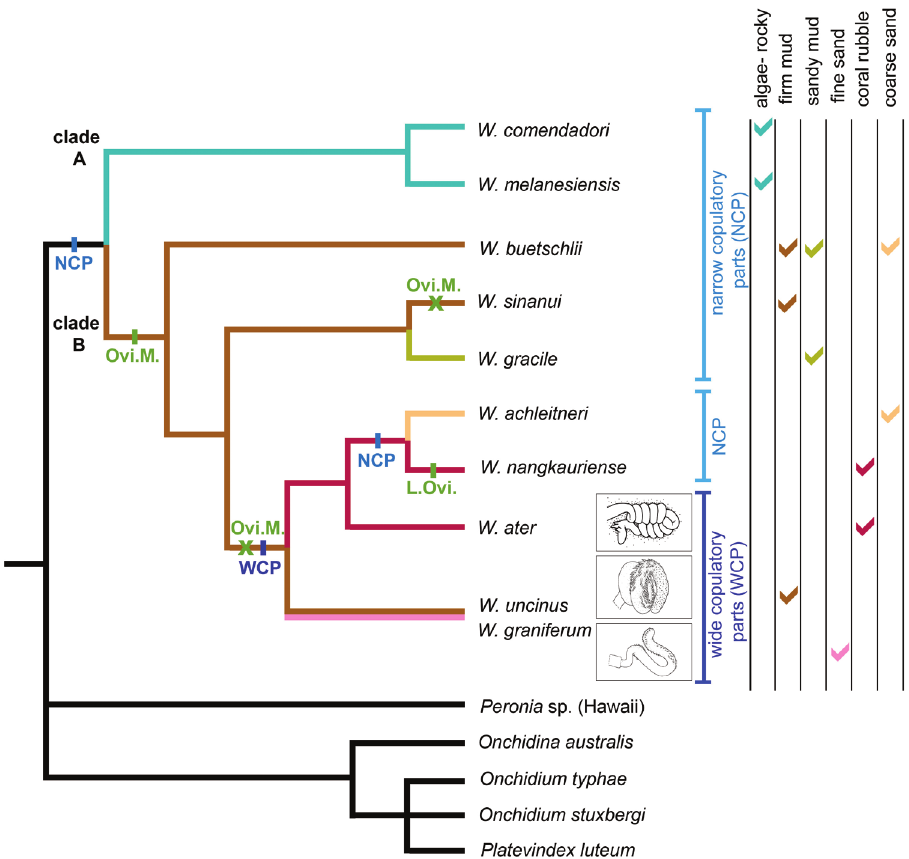
Figure 66. Phylogenetic relationships of Wallaconchis species, with shifts in habitat and character state mapped (for the details on node support and numbers of specimens included in each species, see Figs 1–5). Abbreviations L.Ovi. long oviduct NCP narrow copulatory parts Ovi.M. oviduct membrane WCP wide copulatory